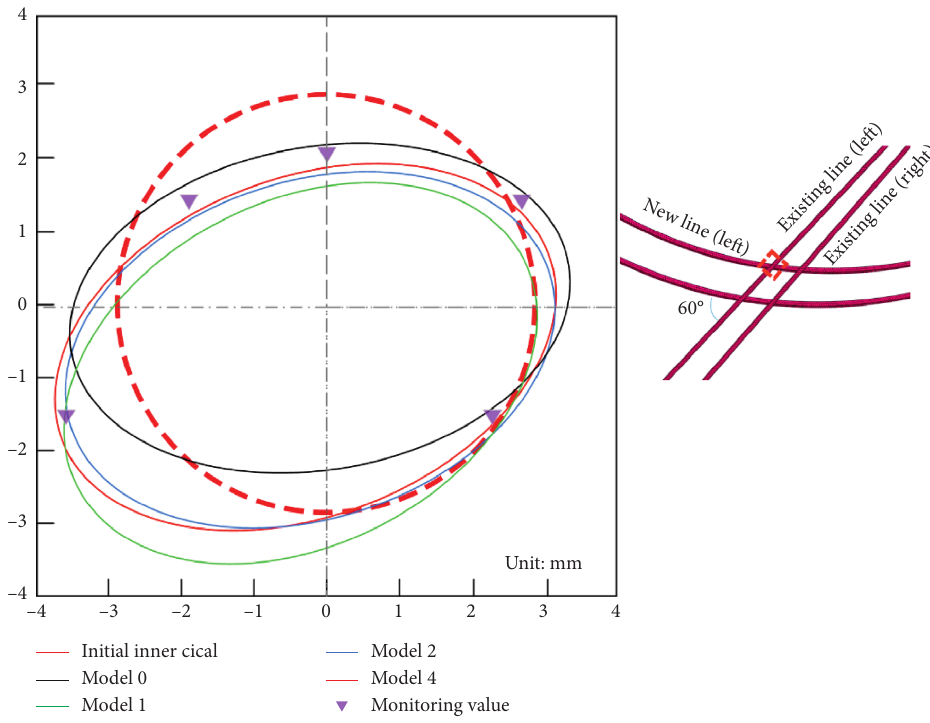
Figure 10: Convergence ellipse diagram of undercrossed section.